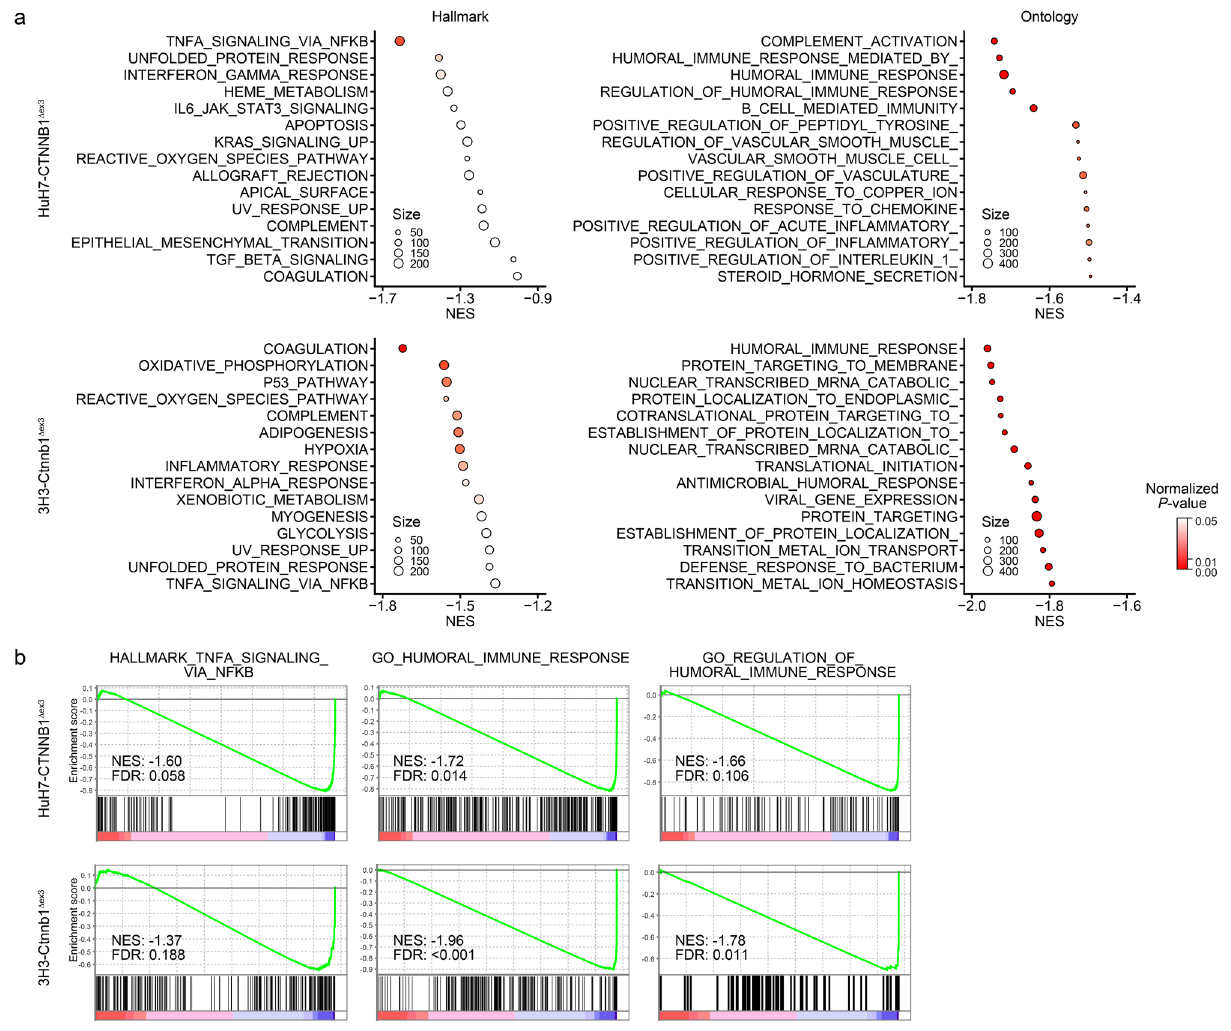
Figure 3. Alteration of signaling pathways by exon 3 skipping of β-catenin in HCC. ( a ) Bubble plots of gene sets negatively enriched in the HuH7-CTNNB1 Δex3 and 3H3-Ctnnb1 Δex3 cells. ( b ) Enrichment plots of gene sets commonly associated with the HuH7-CTNNB1 Δex3 and 3H3-Ctnnb1 Δex3 cells. Hallmark (H: hallmark) and ontology (C5.BP: gene ontology biological process) gene sets were obtained from the MSigDB. Normalized enrichment score (NES), normalized P -value and false discovery rate (FDR) were calculated by the GSEA